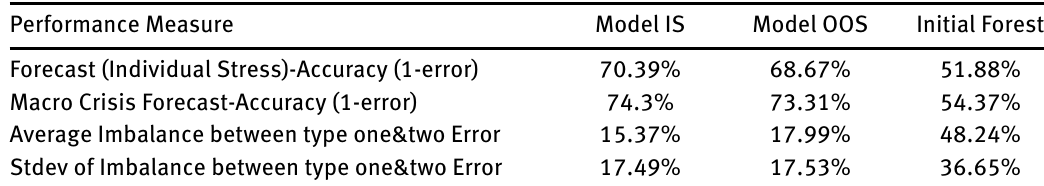
Table 3: Summary of results of in-sample and out-of-sample model application compared to the results of the unchanged dataset including the sample information. The measures are shown in % of the underlying